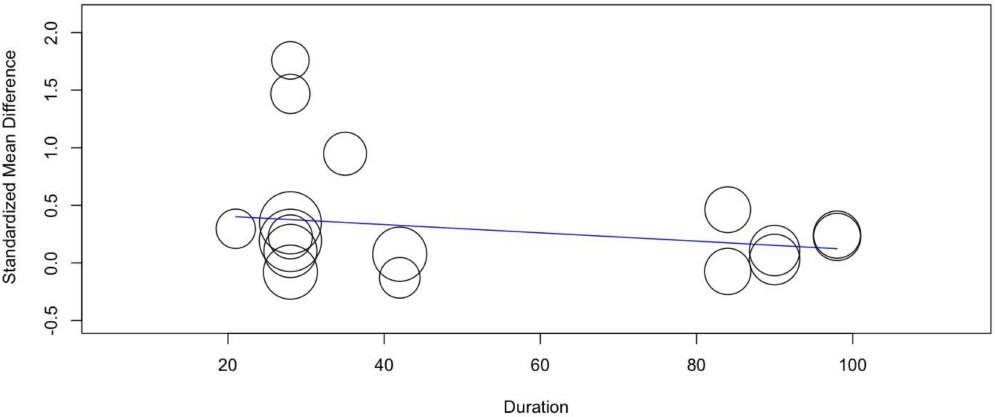
Figure 7. Results of the duration variate random-effect meta-regression for SMDs of tests with aerobic metabolism predominance in a highly trained